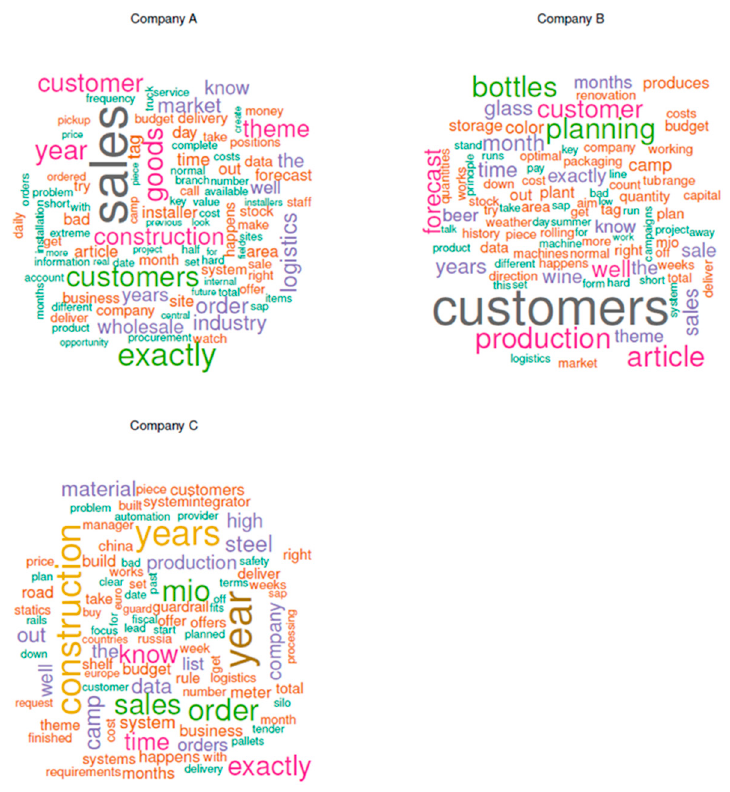
Figure 1. Word clouds for companies A, B, and C.